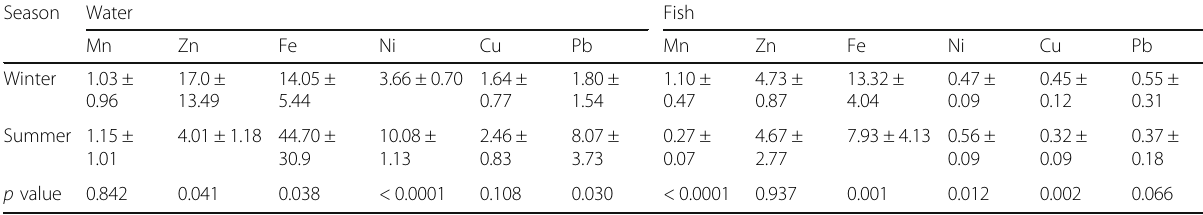
Table 8 Seasonal mean ± SD of heavy metals in water ( μ g/L) and in O. niloticus muscles ( μ g/g wet wt.) from Burullus Lake during 2014 Season